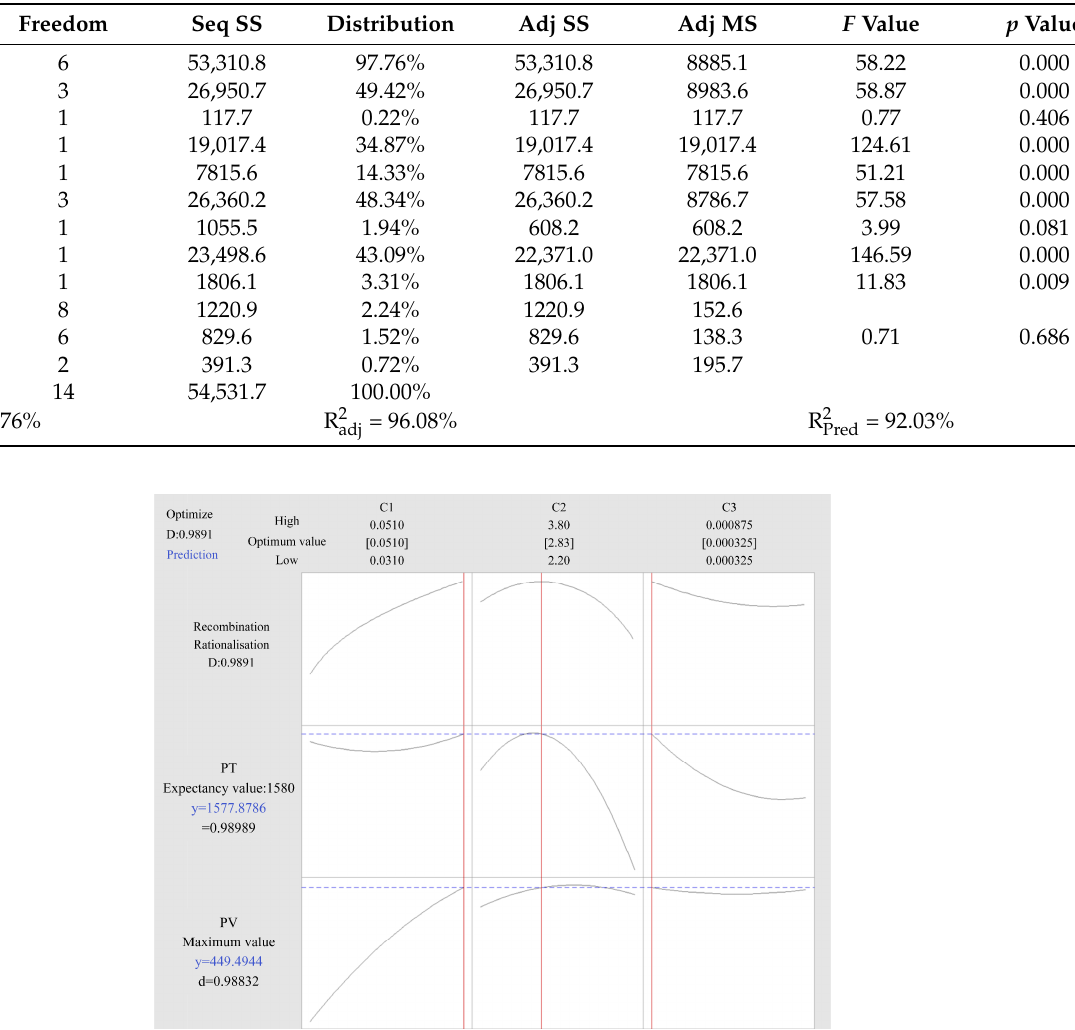
Table 4. Variance analysis of the response value for Pt .